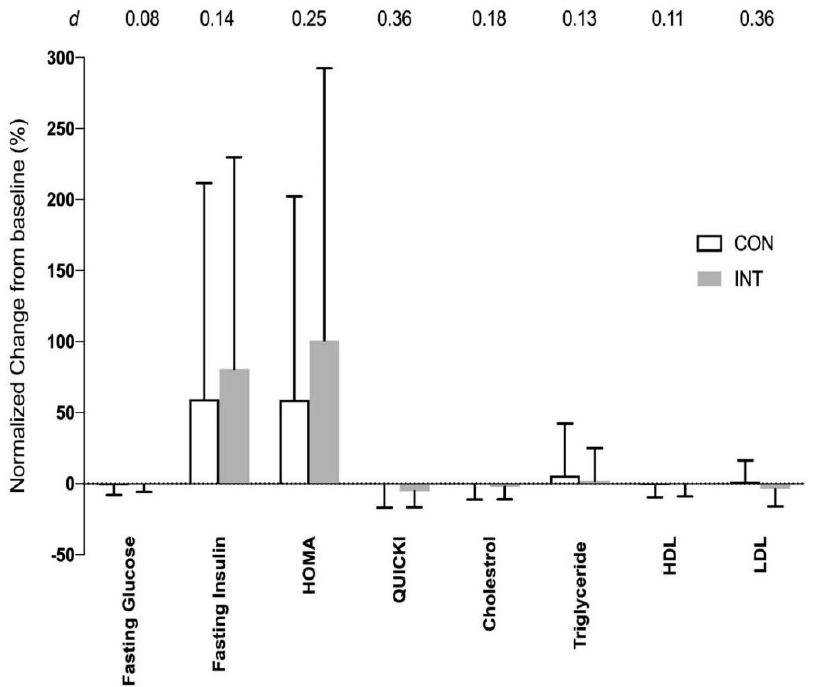
Figure 6. Normalized changes (mean ± SD) in fasting glucose, fasting insulin, Homeostatic model assessment (HOMA), Quantitative insulin-sensitivity check index (QUICKI), total cholesterol, triglyceride, high-density lipoprotein (HDL), low-density lipoprotein (LDL) from baseline (0%) to post-6 weeks training for non-training or control (CON , N = 17) group and intervention training (INT; N = 16) group. Effect size ( d ) for the difference between CON and INT groups is shown on the top of the graph.